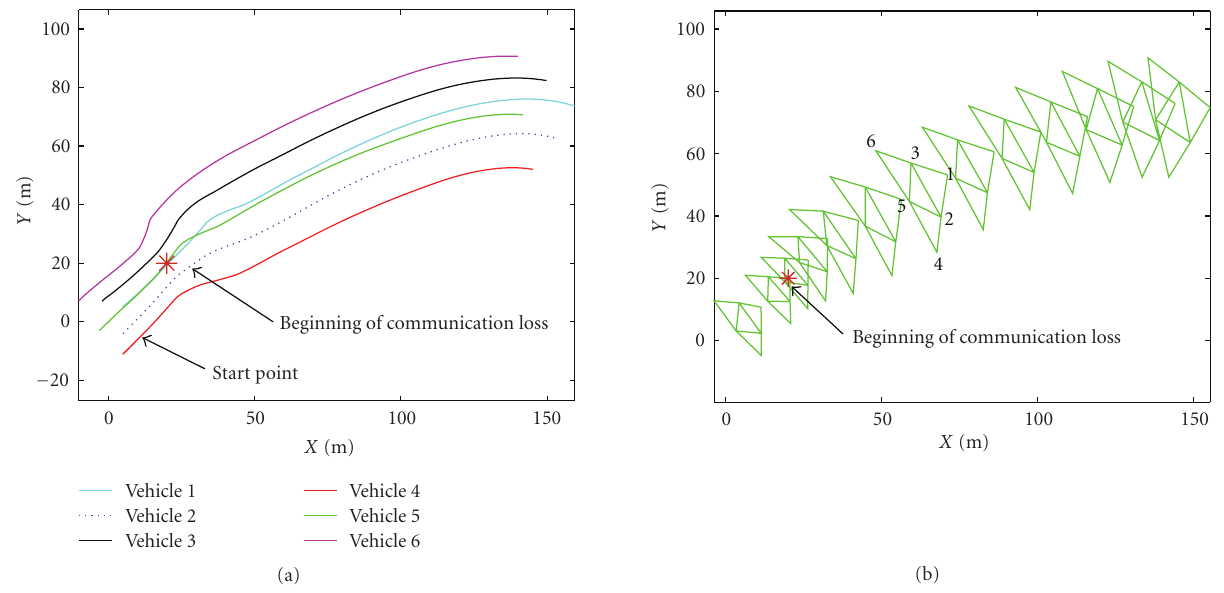
Figure 8: Trajectory (a) and formation snapshot (b) of six vehicles in triangular formations when Algorithm 2 is used.